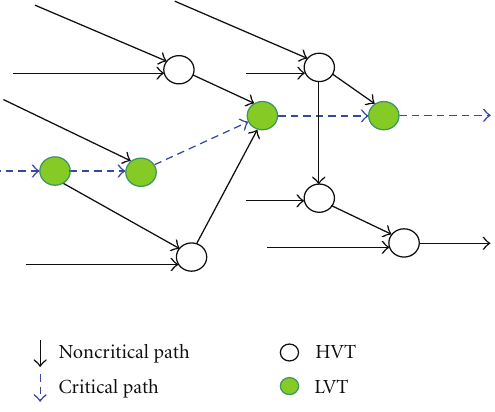
Figure 1: Circuit with two types of gates.